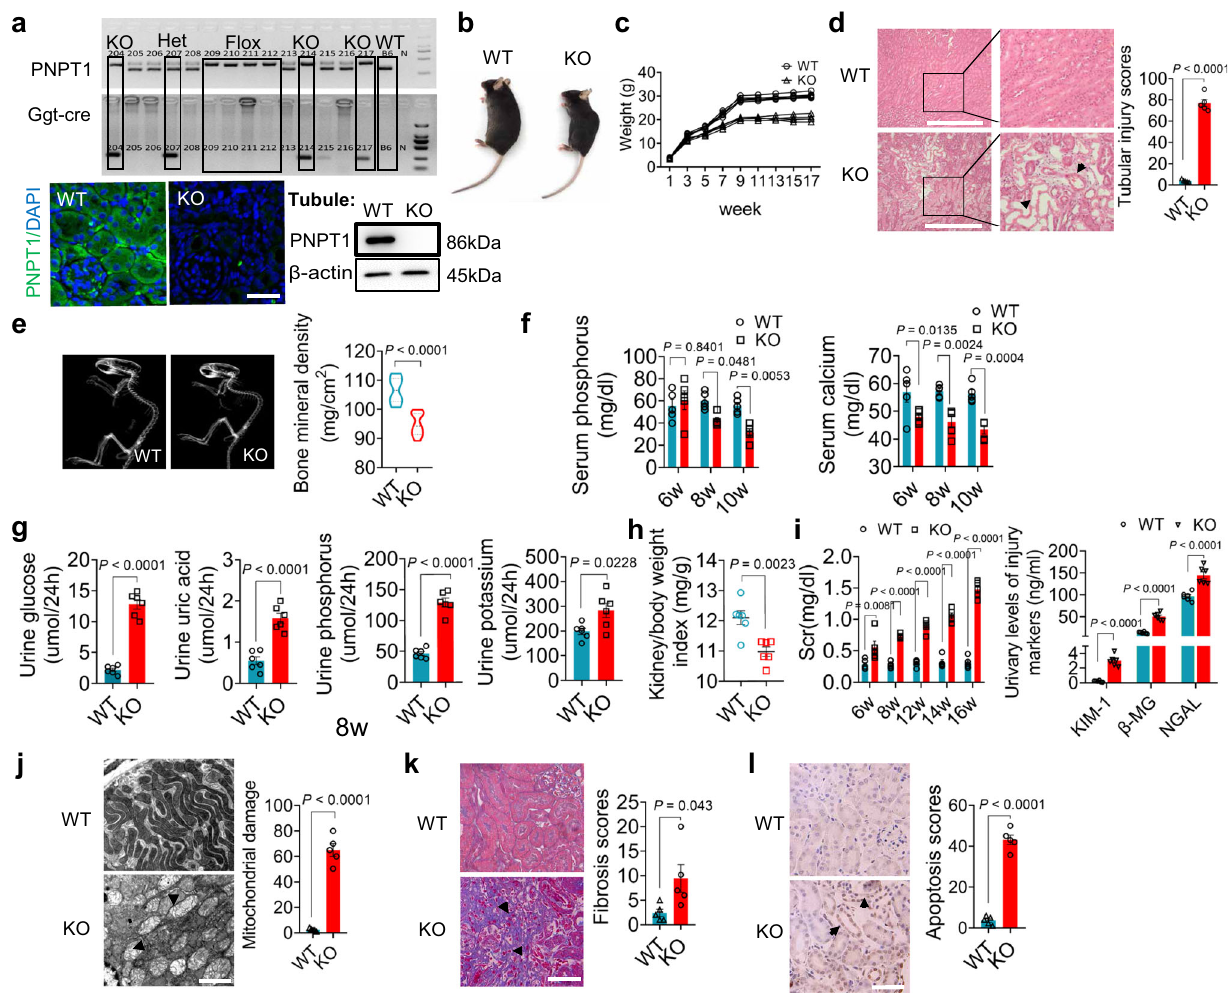
Fig. 7 | Renal tubular-speci fi c PNPT1 -/- mice displayed impaired reabsorption and renal tubular injury. a Top: genotype identi fi cation and PNPT1 levels in WT and renal tubular-speci fi c PNPT1-KO (KO) mice. Bottom: immuno fl uorescence labeling and WB analysis of PNPT1 in WT and KO renal tubules. b Image of WT and KOmice. c WeightmonitoringofWTandKOmice(7mice/group). d Tubularinjury scorein WT and KO mice (5mice/group,8w).Arrows: injured tubules. e Left: Bone mineraldensityscanningofWTandKOmice.Right:quanti fi cationofbonemineral density (10 mice/group, 8w). f Levels of serum calcium and phosphorus (5 mice/ group,6-10w). g Urinelevelofglucose,uricacid,phosphorusandpotassiuminWT and KO mice (6mice/group,8w). h Kidney/body weight index (6mice/group,8w). i Serumcreatinine(Scr,left)andlevelsofrenaltubularinjurymarkers(right)inWT and KO mice (5 mice/group, 8w). j Left: TEM image of mitochondrial damage in